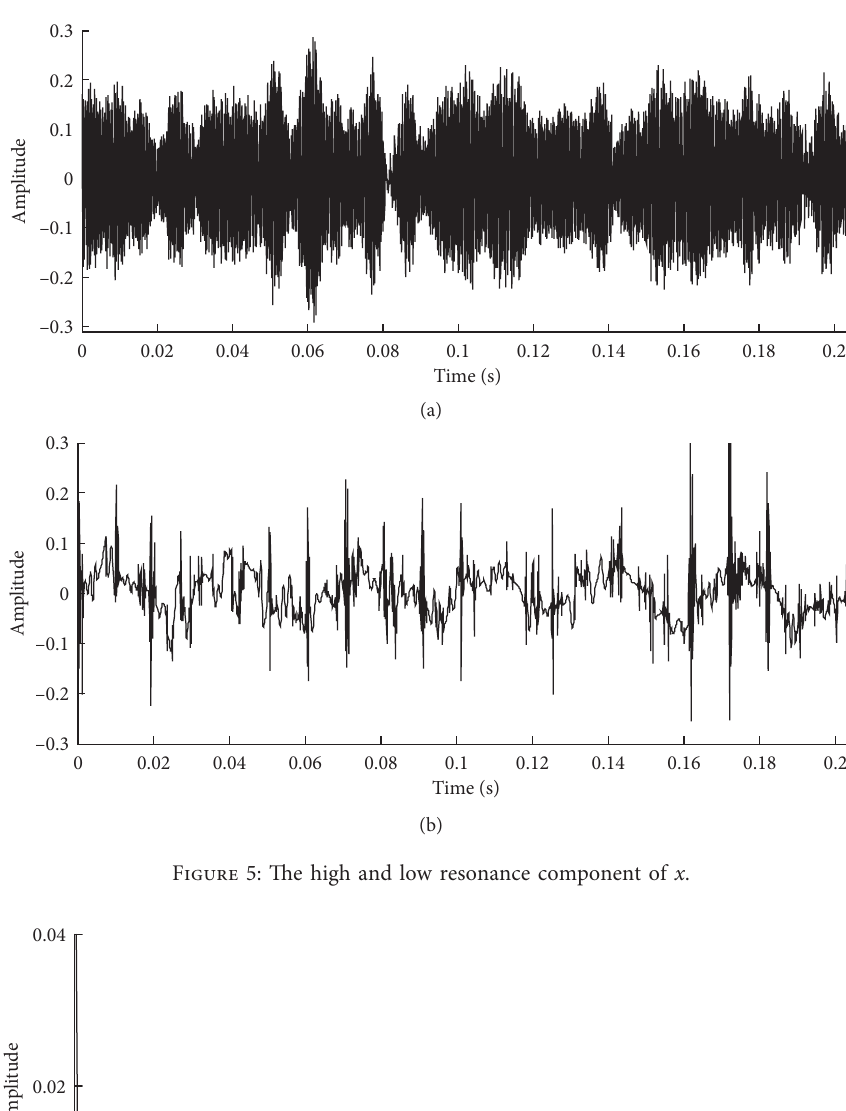
Figure 6: The Hilbert envelope spectrum of low resonance component of x